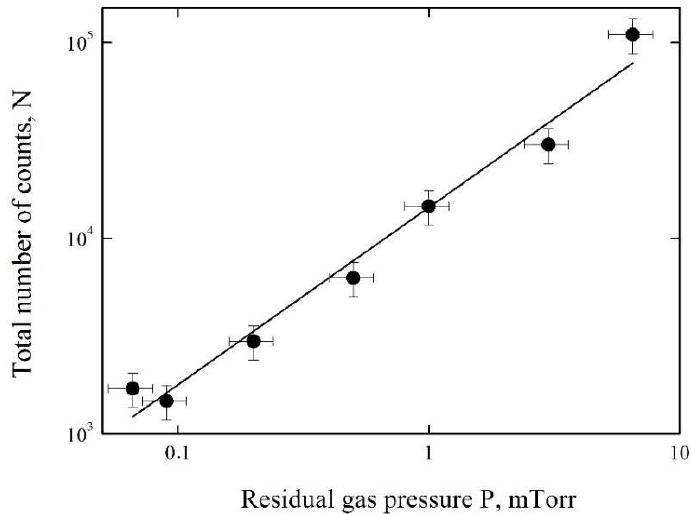
Figure 5. The X-ray yield as a function of the residual gas pressure. The experimental data are shown by points, calculations by Equation (1) are shown by the solid line.